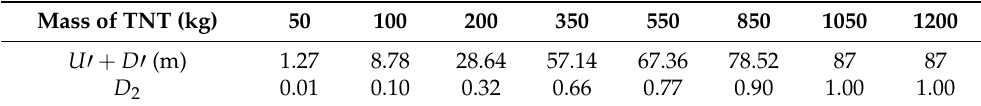
Table 3. Degree of damage to deep flood discharge holes when subjected to underwater contact